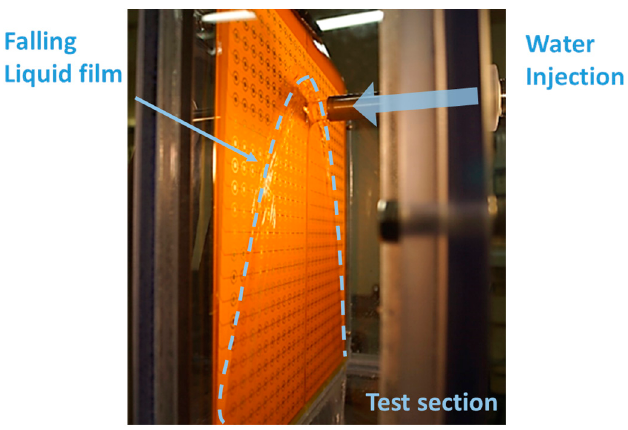
Figure 16. Edge of falling liquid film. Table 1. Span and accuracy of the measurement instrument.